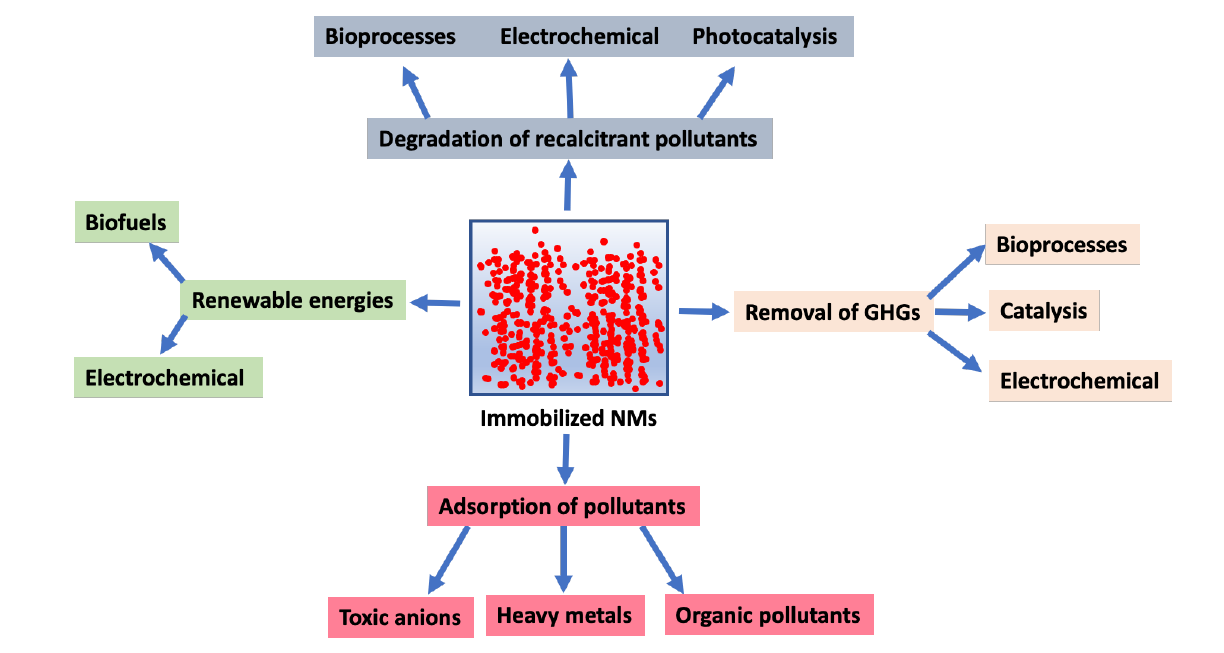
Figure 1. Key environmental applications of immobilized nanomaterials (NMs). GHGs, greenhouse gases.